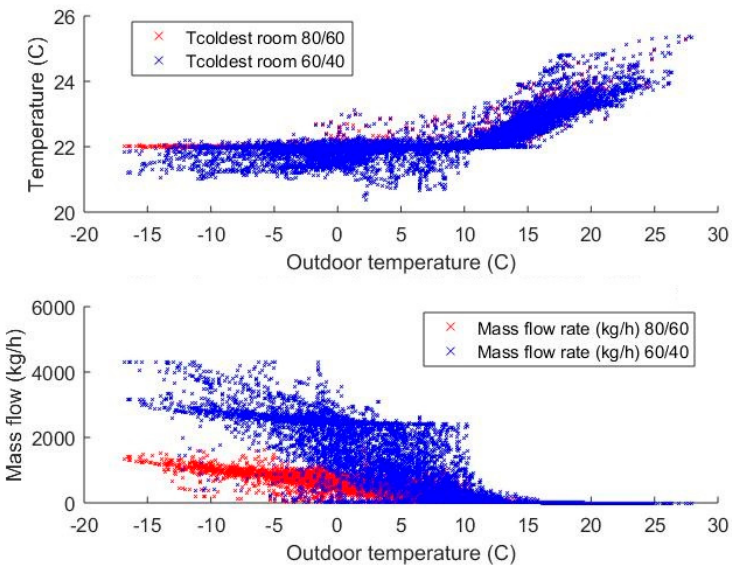
Figure 6. Temperature in the coldest room ( top ) and mass flow rates ( bottom ) relative to the outdoor temperature for AB_03 intermediate renovated.